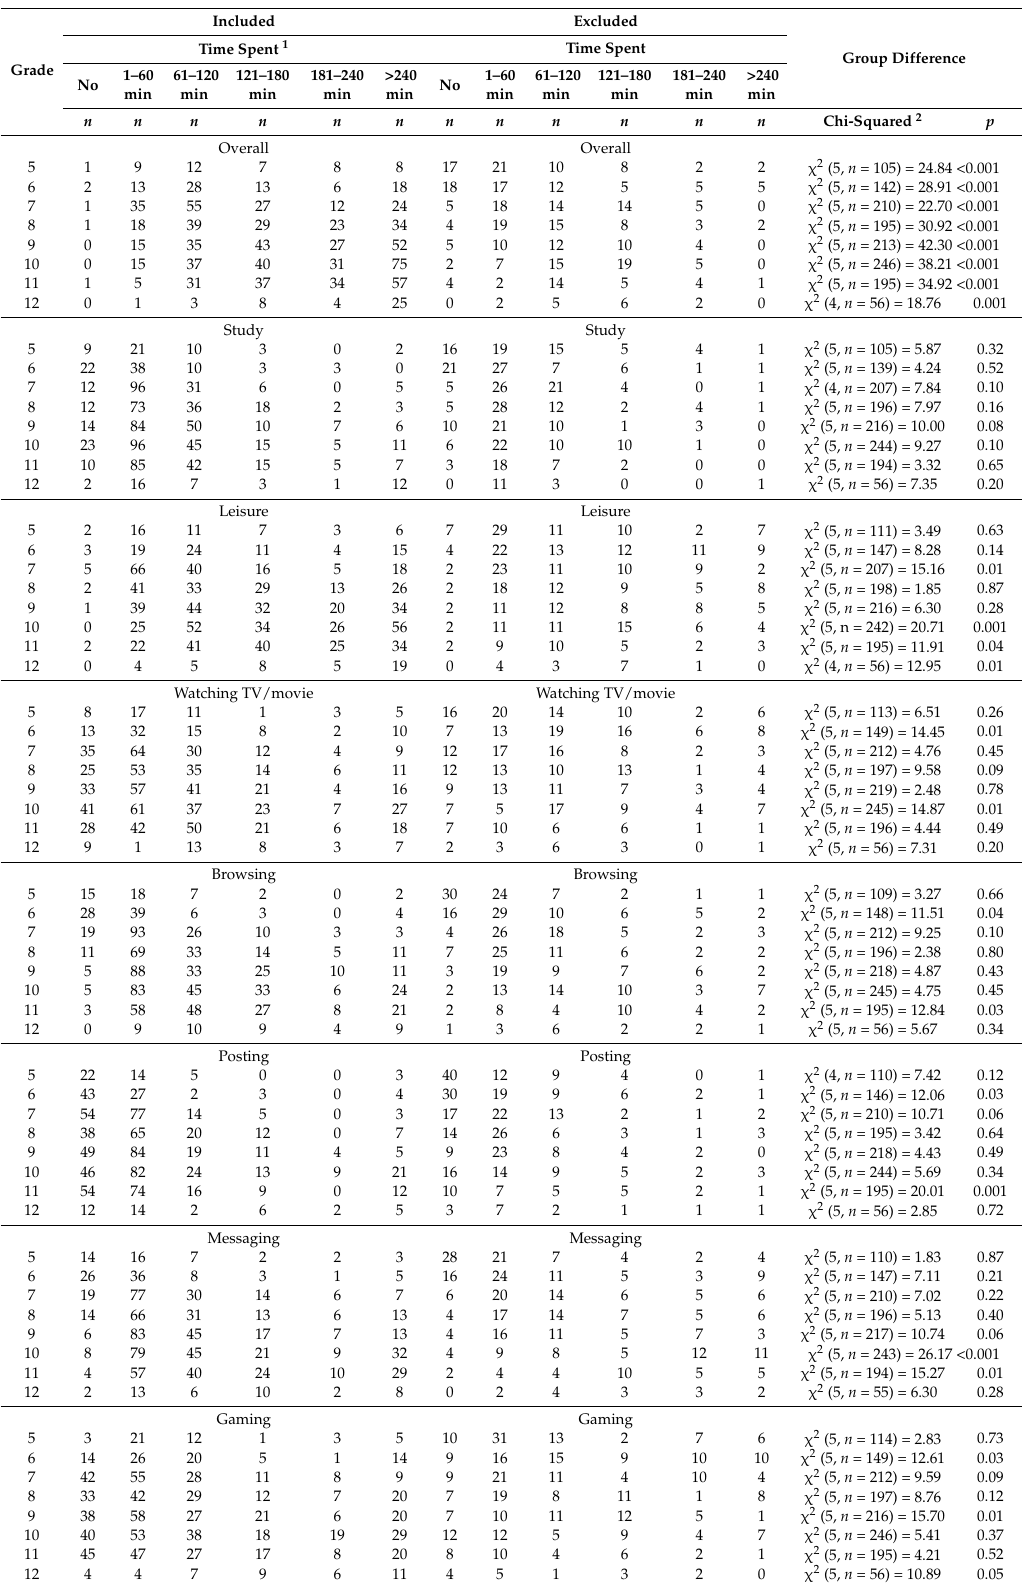
Table A5. Differences in time spent on smart device activities, overall use and its purposes between included and excluded respondents by